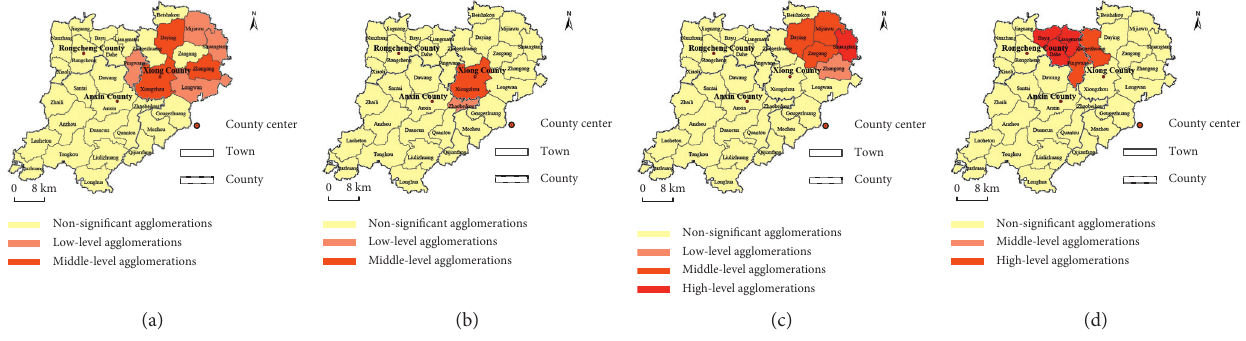
Figure 4: Hot spot distribution of supply chain e-commerce enterprises in Xiong’an New Area. (a) Production wholesalers. (b) Retailers. (c) Distribution wholesalers. (d) Comprehensive suppliers.